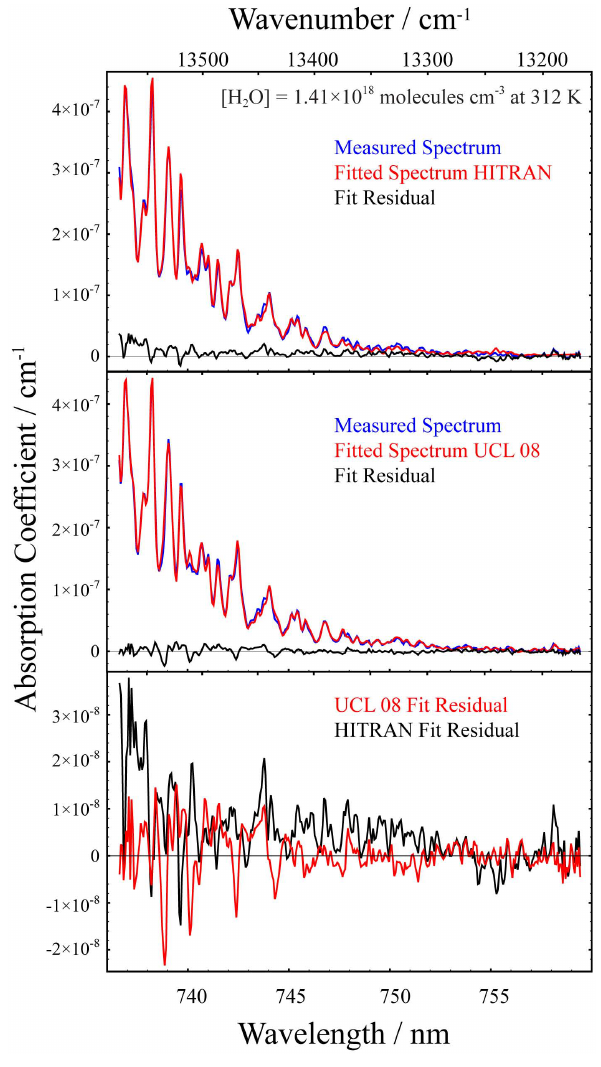
Fig. 5. BBCRDS spectrum of water vapour at approx 85% RH and 312K recorded in air at 1 atmosphere total pressure. The BBCRDS spectrum (blue) is fitted with monomer absorption cross sections calculated using the HITRAN08 (red, top panel) and UCL08 line lists (red, middle panel). The residual spectra are shown in black, and are reproduced on an expanded scale in the bottom